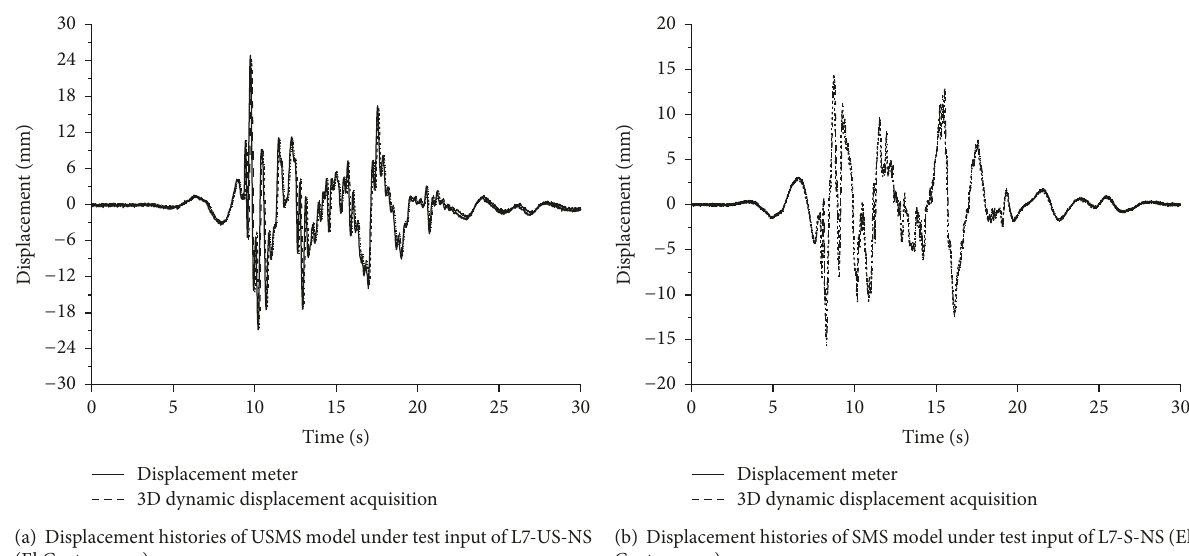
Figure 8: The displacement histories measured by the displacement meters and 3D dynamic displacement acquisition system.